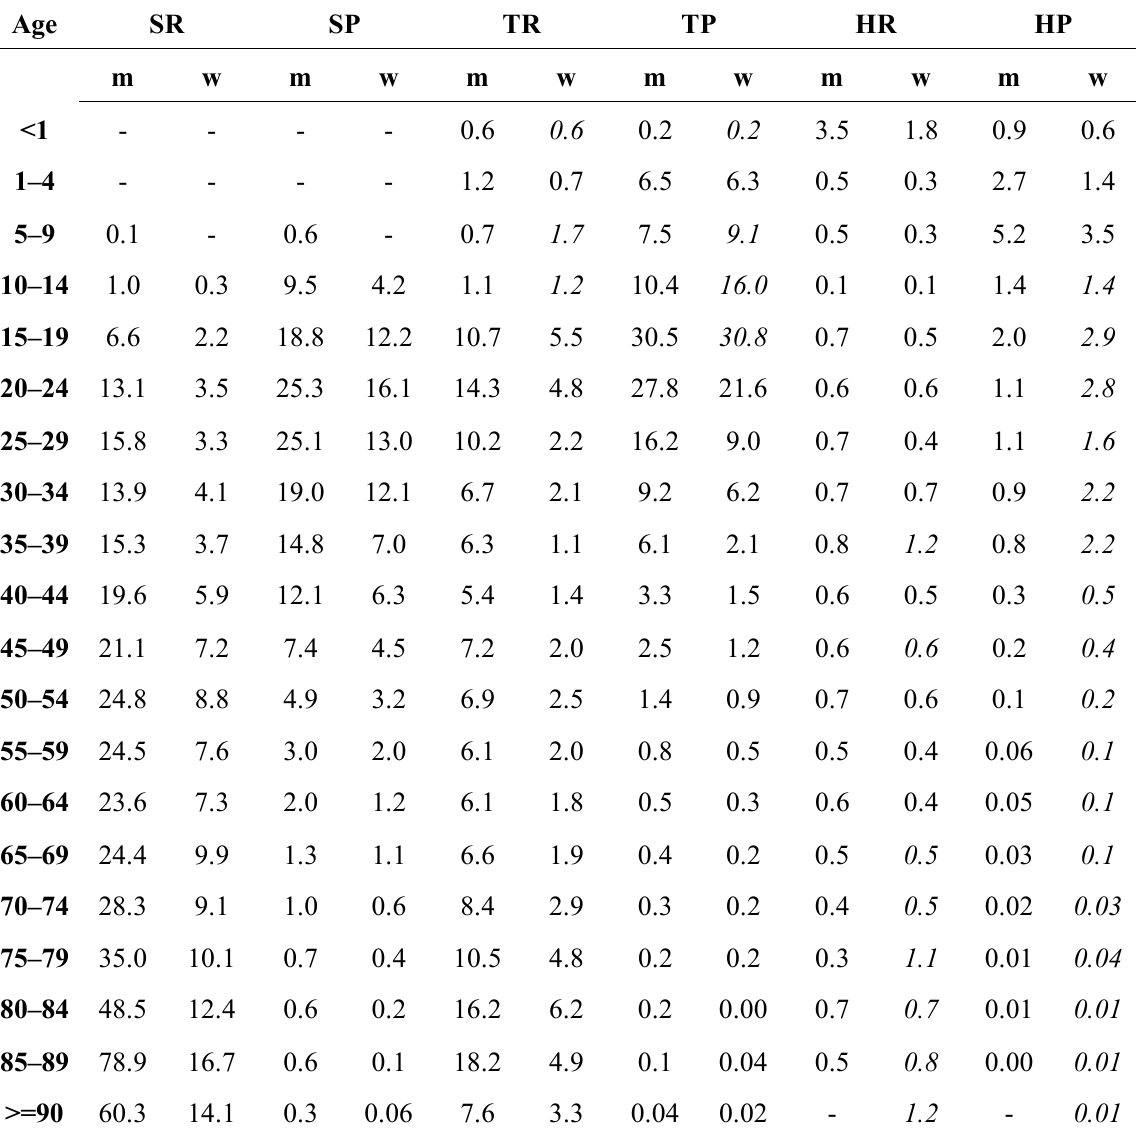
Table 2. Event rates (per 100,000 inhabitants) and proportions (per 100 deaths of all deaths causes) of suicide (SR,SP), traffic accident deaths (TR,TP) and homicide (HR,HP) in Germany 2010, stratified by sex and